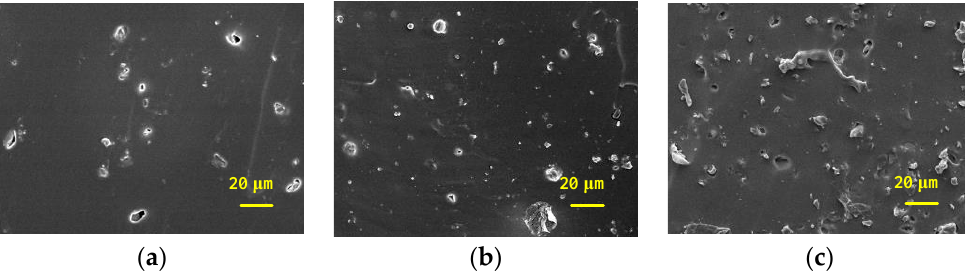
Figure 6. SEM observation of carbon black/PDMS composite: ( a ) carbon black content of 0.5 wt%; ( b ) carbon black content of 2 wt%; and ( c ) carbon black content of 4 wt%.